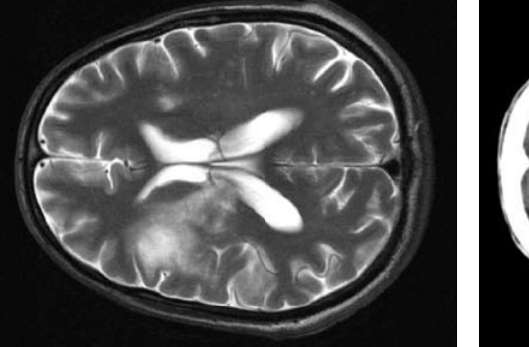
Fig. 2. T2WI shows hyperintense signal in white matter right parietal lobe with involvement of the subcortical U-fibres and mild mass effect. The right basal ganglia and left anterior capsula externa lesions are again demonstrated.